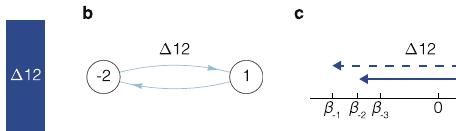
longitudinal k -components of the involved modes. A mode-converting mirror that converts mode i into − j (blue arrow) will also convert mode j to − i . (blue dashed arrow). d A potential, physical implementation of the mode-converting mirror in realspaceisarectangulargratingwhoseperiodicity Λ isdeterminedbythedistance between the modes in k